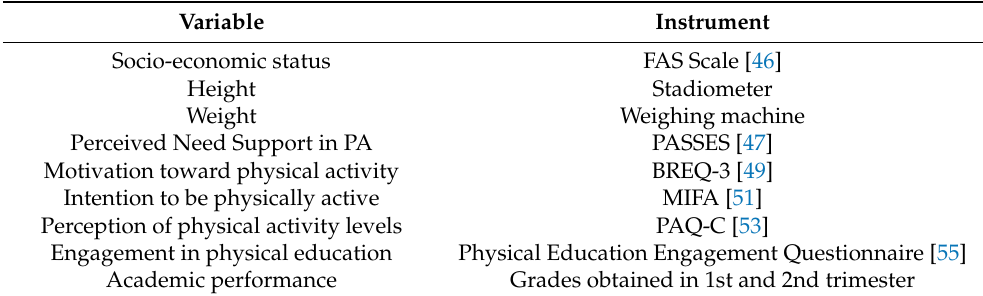
Table 1. Summary variables and instruments to measure them used in